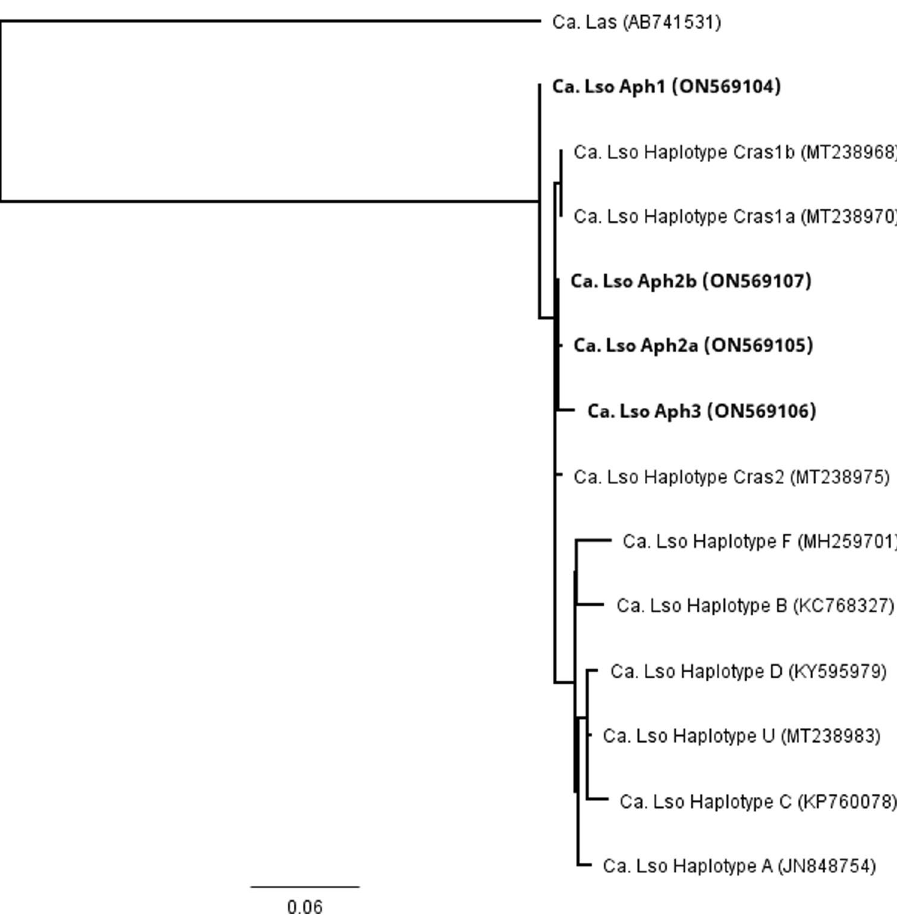
Figure 3. Unrooted phylogenetic tree constructed using a 586-basepair region of the outer membrane protein gene from Ca. Liberibacter species. Abbreviations used were Ca. Lso ( Ca. L. solanacearum) and Ca. Las ( Ca. L. asiaticus). GenBank accession numbers are indicated in parentheses and specimens identified in this study are indicated in bold font. Bar length represents substitutions per